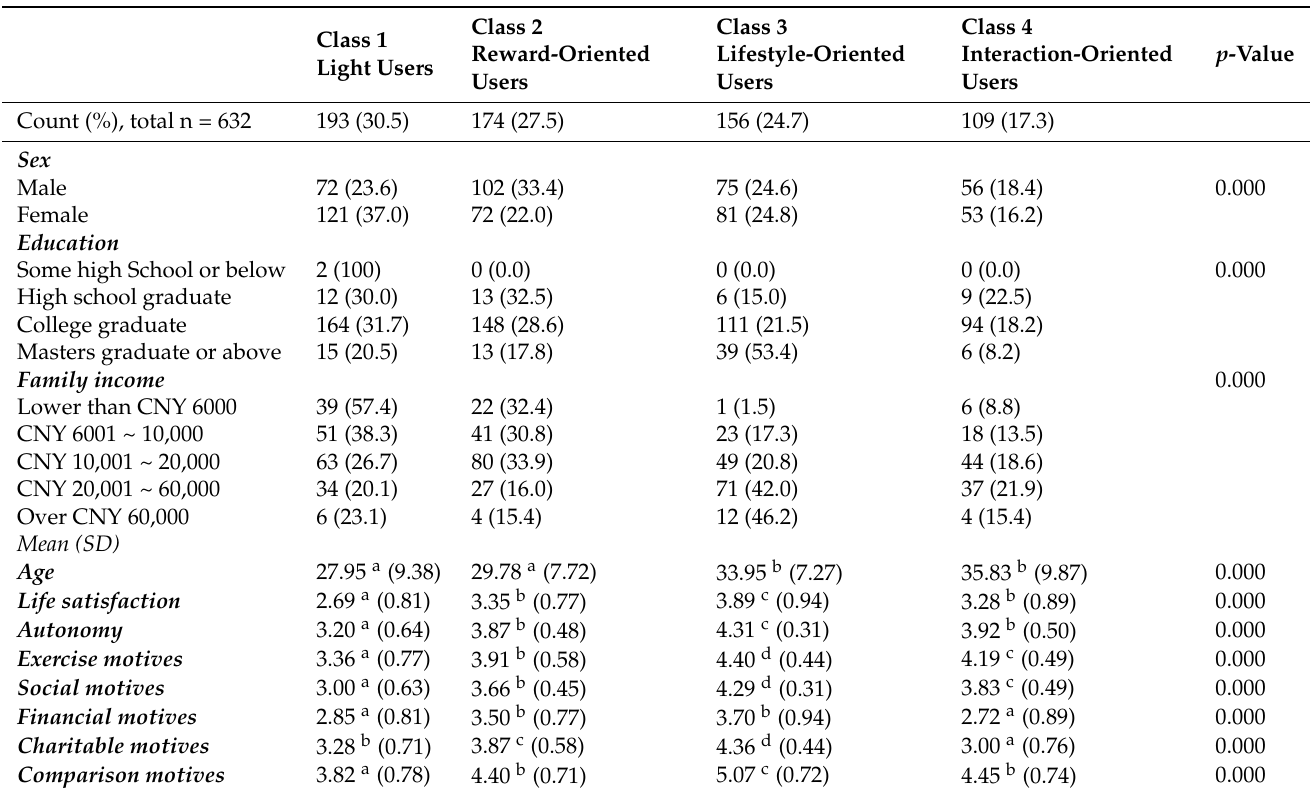
Table 6. Fitness users’ characteristics across four